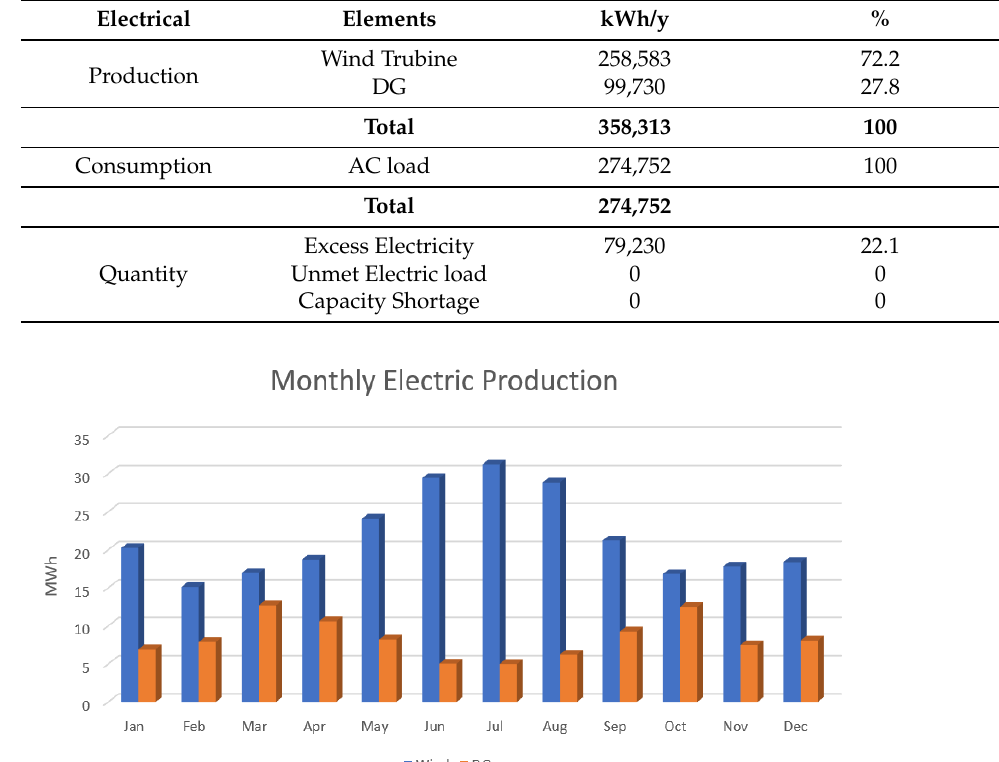
Table 7. Augmented Electrical Result for Wind/Battery/DG.